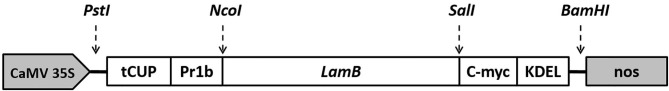
Schematic representation of T-DNA region of the expression vector (pMYC-LamB) construct used for W. globosa transformation. Transgene expression fragment (LamB) was placed under the control of the cauliflower mosaic virus 35S promoter, tCUP, translational enhancer from the tobacco cryptic upstream promoter; Pr1b, tobacco pathogenesis related 1b protein secretary signal peptide; C-myc, detection/purification tag; KDEL, endoplasmic reticulum retrieval tetrapeptide; nos, nopaline synthase transcription terminator.